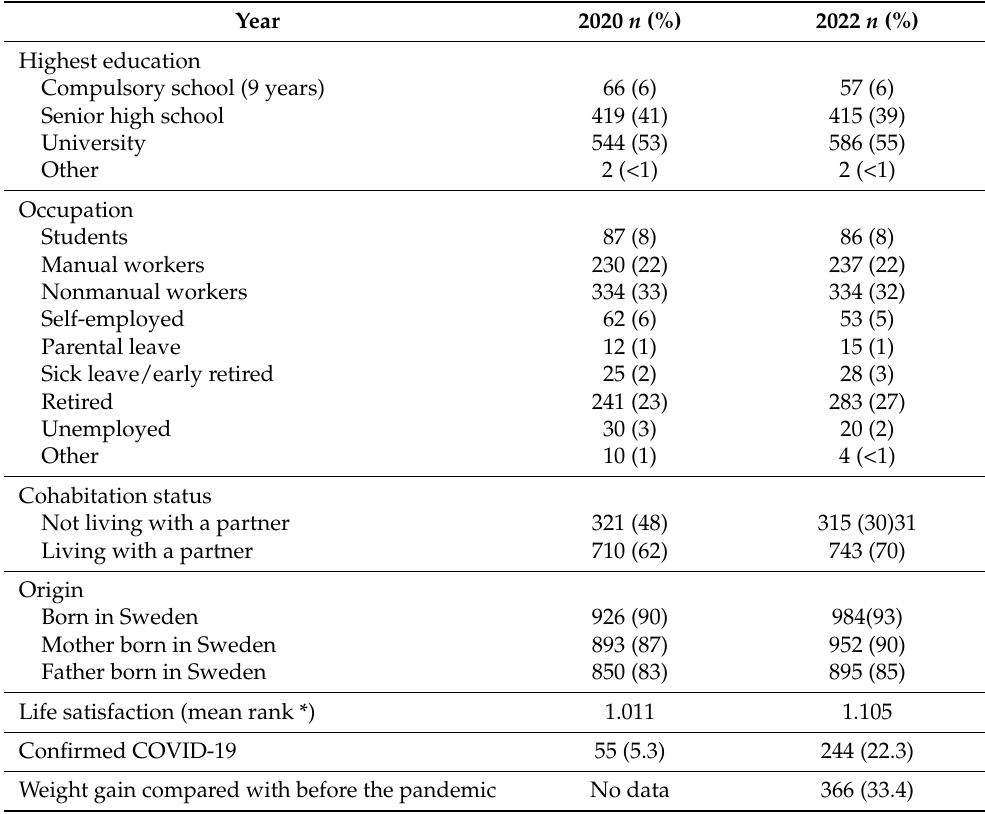
Table 1. Demographic characteristics for the two